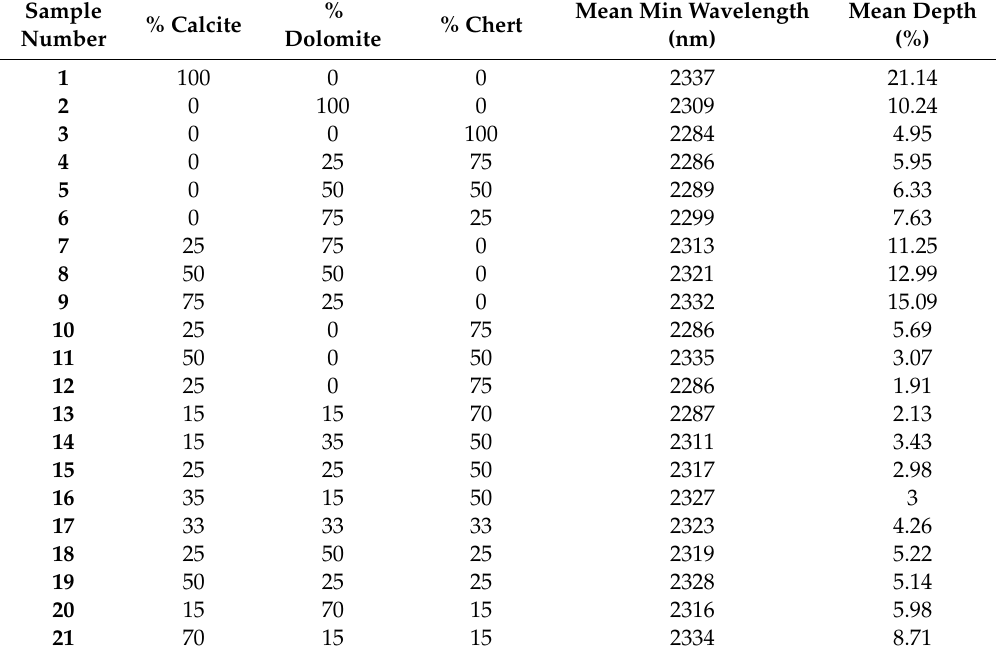
Table 1. Mineral abundances (by mass) and mean absorption minimum locations measured from hyperspectral imaging